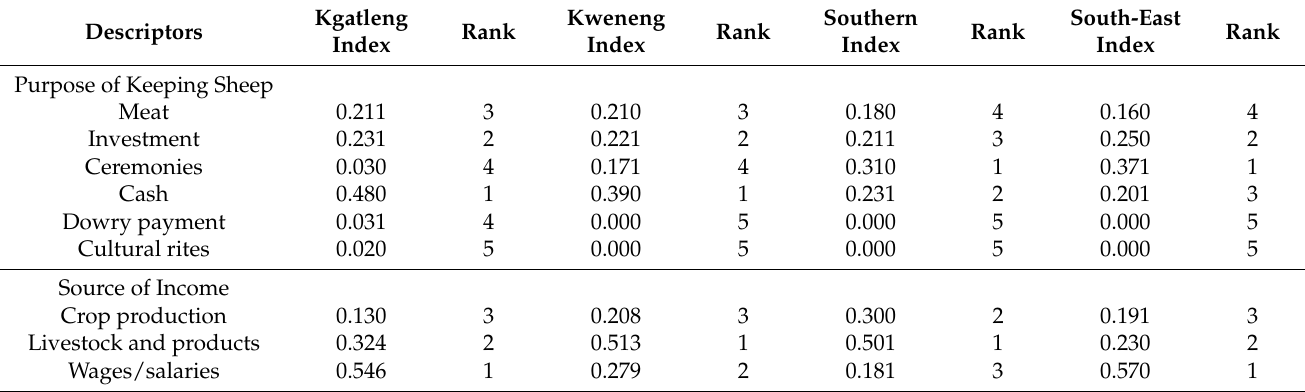
Table 3. Indices and their ranking for reasons for keeping sheep and source of income by respondents in surveyed districts of Botswana.